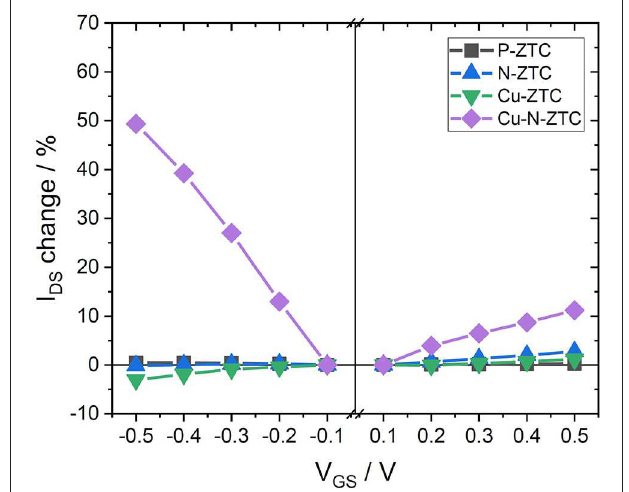
FIGURE 4 | ISFET characteristic curve of Cu doped